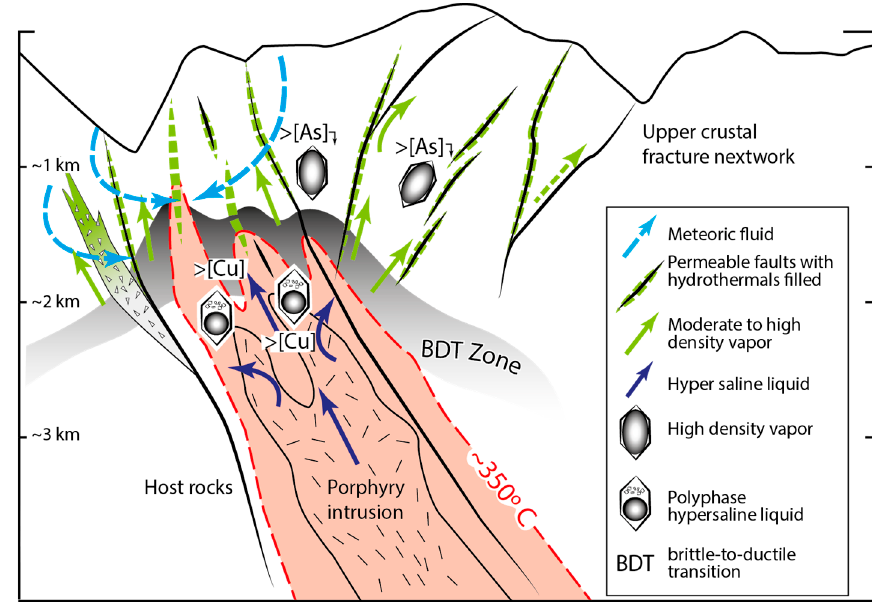
Figure 1. The conceptual schema of an idealized porphyry Cu-Mo deposit showing the ore-fluid phase separation and the As-Cu geochemical partitioning (simplified from Reference [23]). The brittle-to-ductile transition (BDT) zone is simplified from Reference [25].